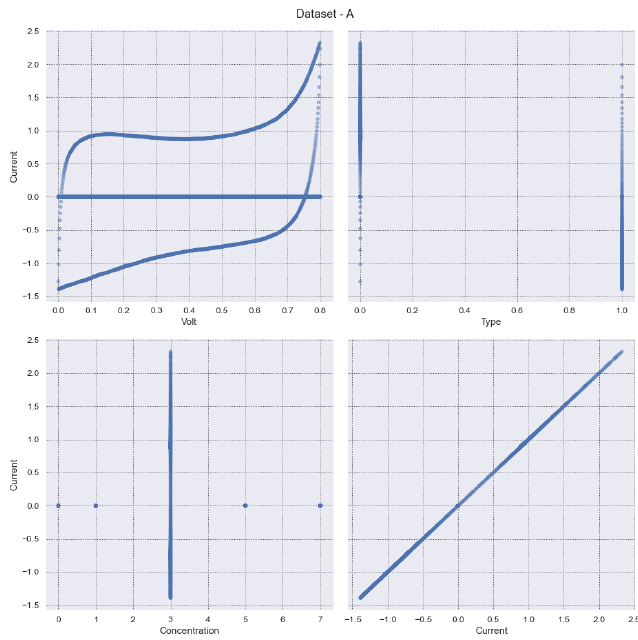
Figure 8. Scatter plots of Dataset